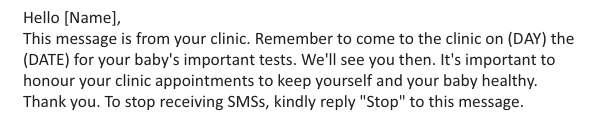
FIGURE 1: Sample SMS message sent to mothers at 1, 4, 10 and 14 weeks post-